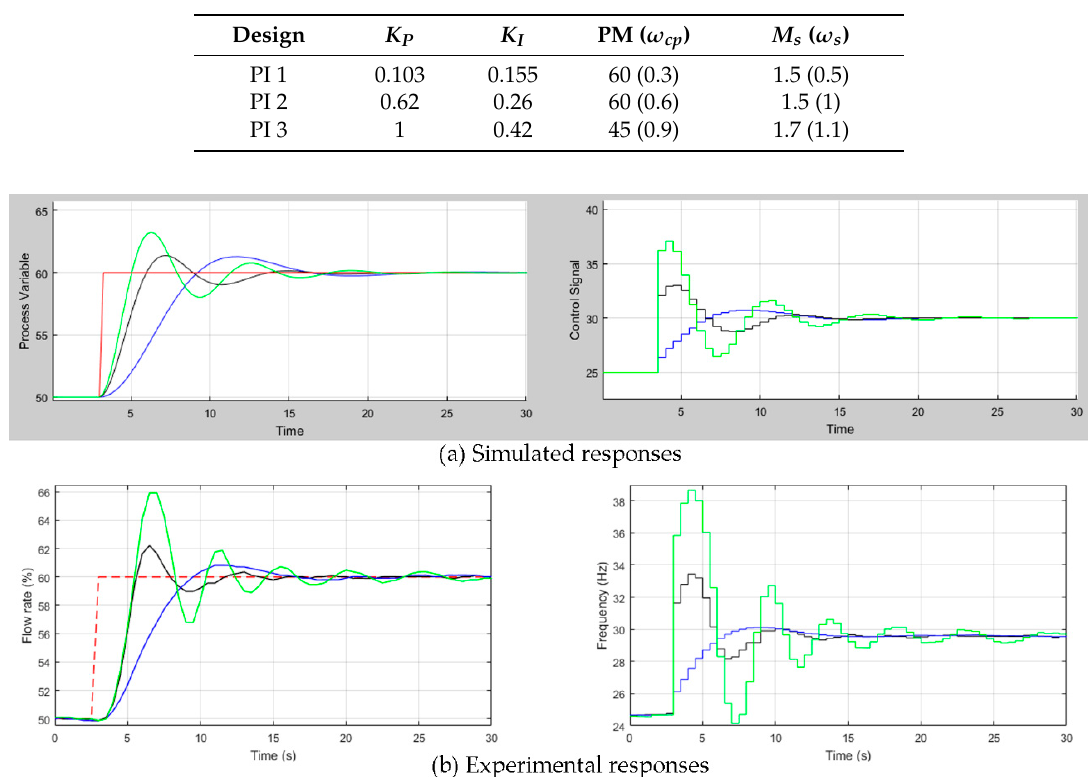
Table 6. Control parameters and specifications obtained from the lab test.